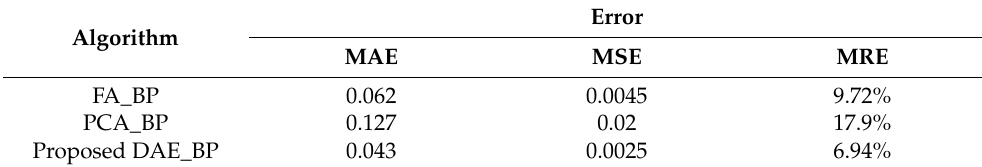
Table 3. Errors in predicting stock prices with different coding sequences.